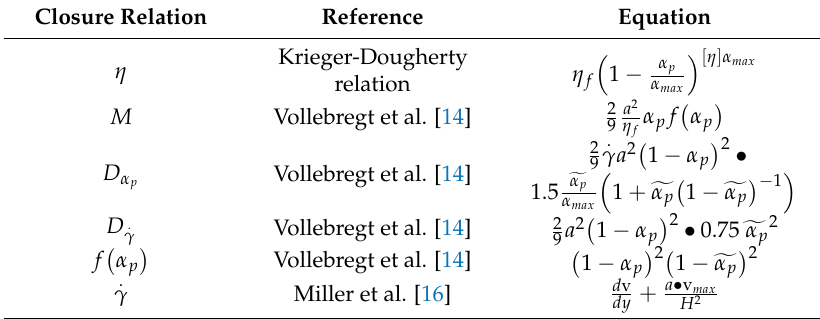
Table 1. Closure relations needed for the shear induced diffusion force.